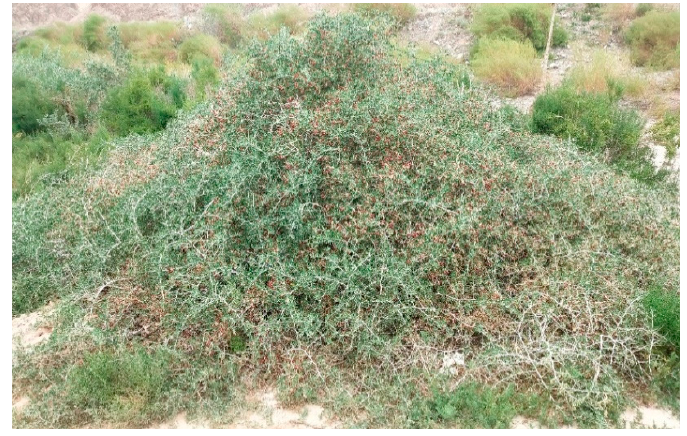
Figure 1. A representative plant of Nitraria tangutorum Bobr. investigated in this study.